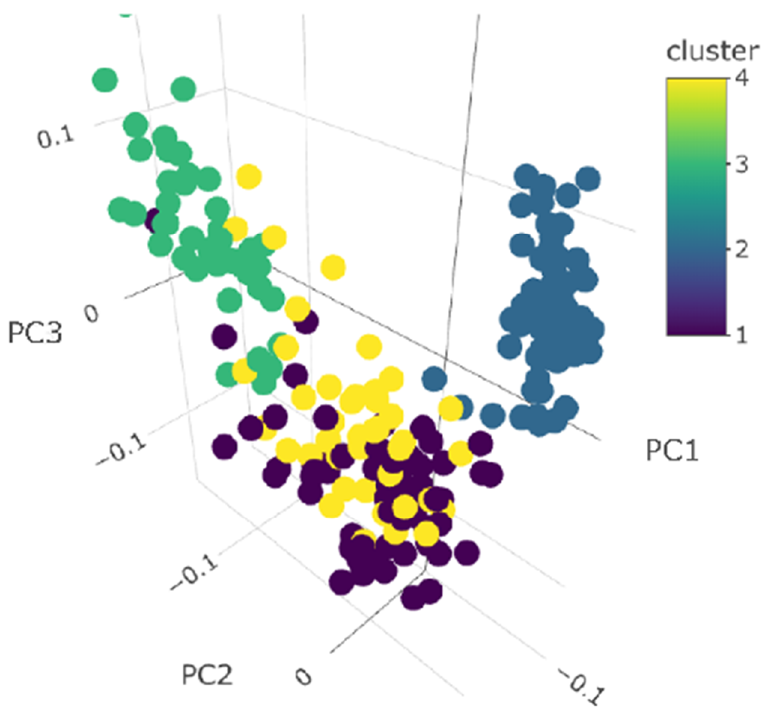
Figure 2. Principal coordinates analysis (PCoA) based on Gower distances. ( A ) PCoA grouped by sampling time. ( B ) PCoA grouped by lactation stage groups. Proportion of variance explained by each principal coordinate axis is denoted in the corresponding axis label. The different colors repre- sent the different sampling points. Early lactation DIM = 20–80, mid-lactation DIM = 81–150, and late-lactation DIM > 150.